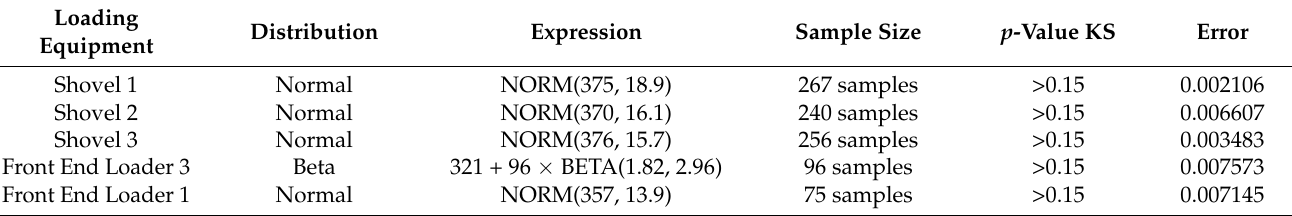
Table 2. PDF of the loaded tonnages for rope shovels and FEL.